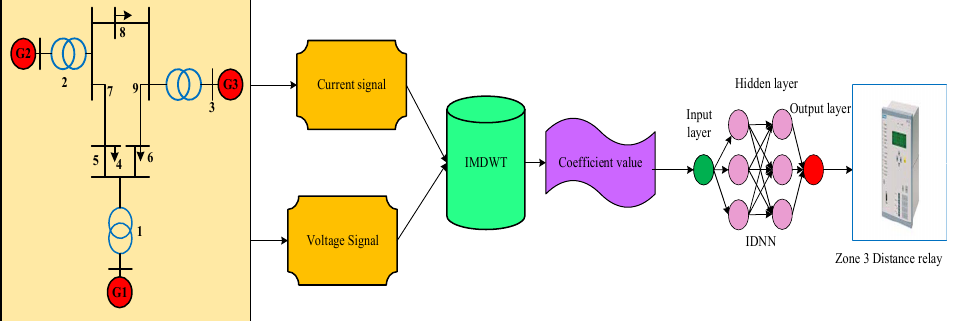
Figure 1. The architecture of the proposed approach.